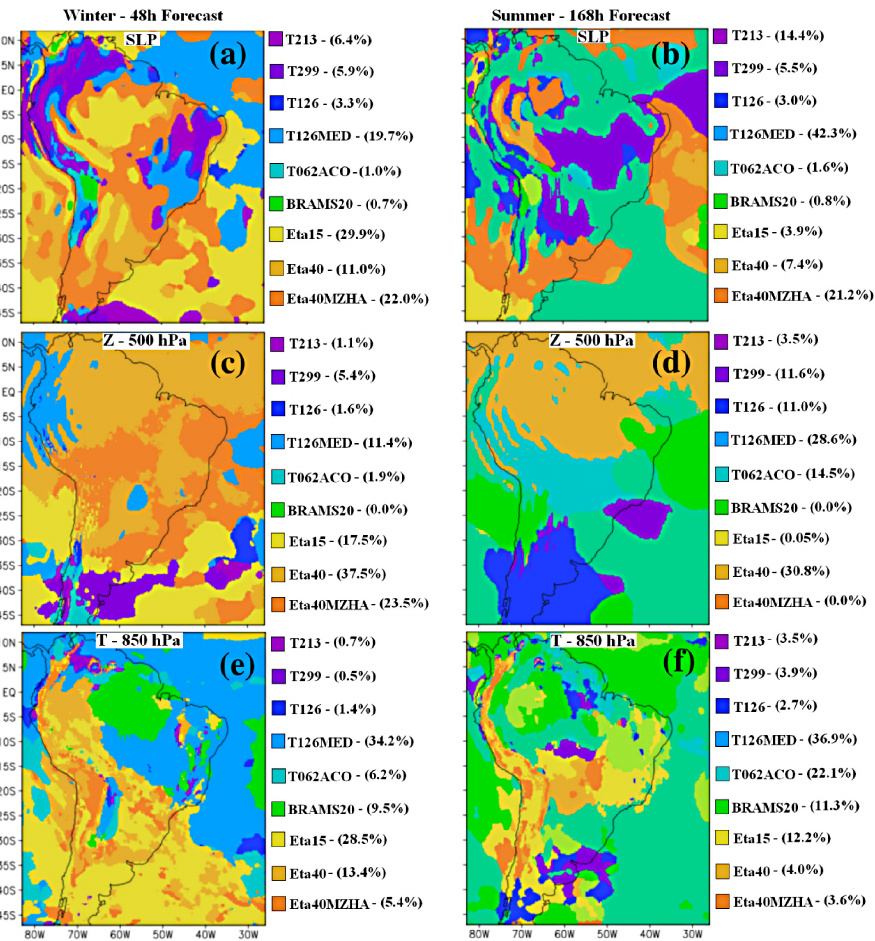
Figure 2. Spatial distribution of grid points from models with smallest values for RMSE of mean sea level pressure (a, b) , 500hPa height (c, d) and 850hPa air temperature (e, f) , for winter (left column) and summer (right